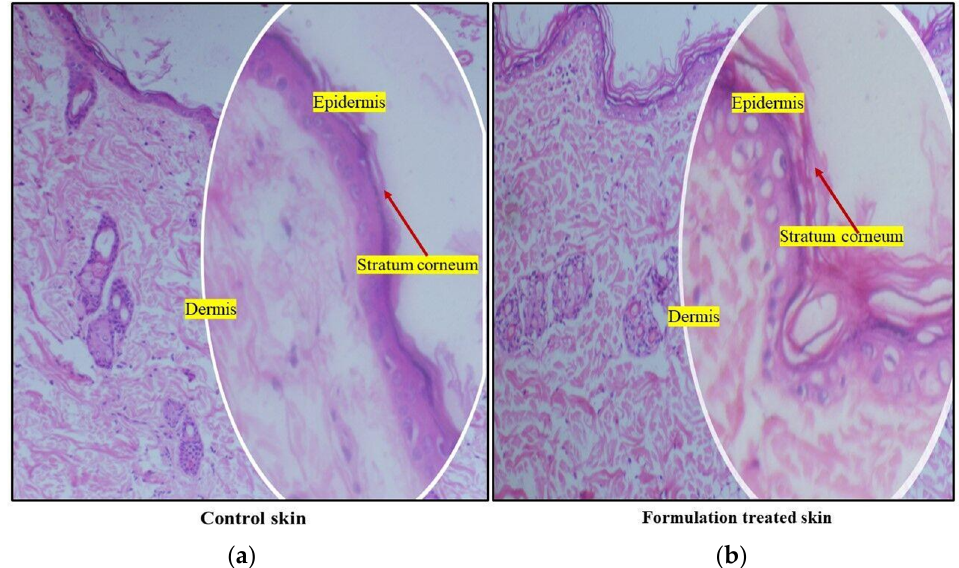
Figure 12. Comparison of histological cross sections of the ( a ) Control skin and ( b ) treated skin (6 h treatment with ethosomal gel) (Magnification; 10× and 40× (within circle).